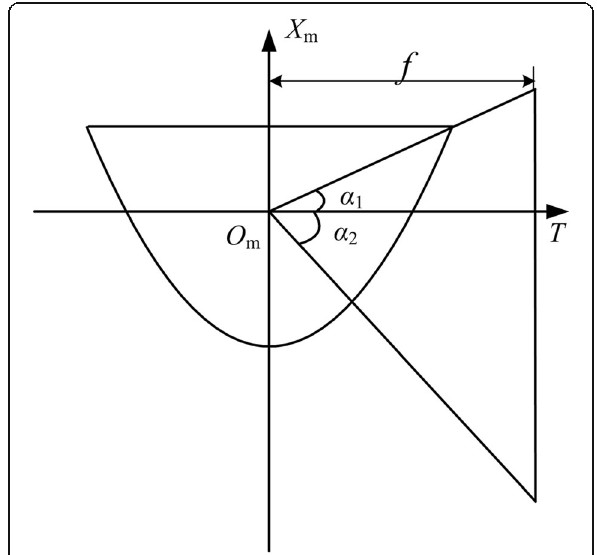
Fig. 4 Coordinate system for a cylindrically expanded